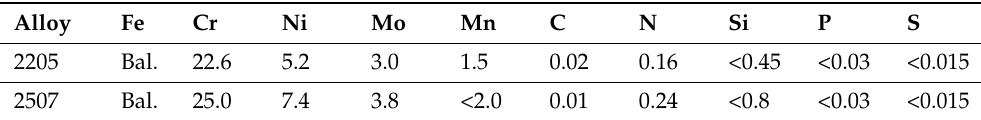
Table 1. Chemical composition (wt.%) of duplex stainless steels 2205 and